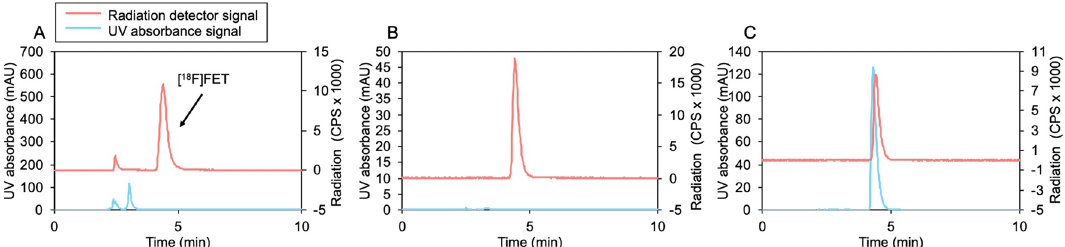
Figure 6. Example HPLC chromatograms for [ 18 F]FET. ( A ) Crude product. ( B ) Formulated product. ( C ) Formulated product co-injected with reference standard.